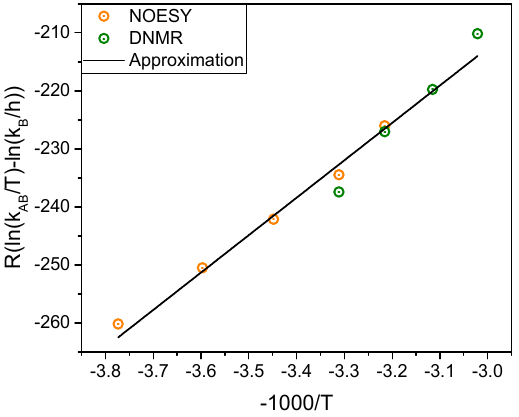
Figure 3. Eyring plot for the nitrogen inversion of the 2 RS/SR diastereomer.